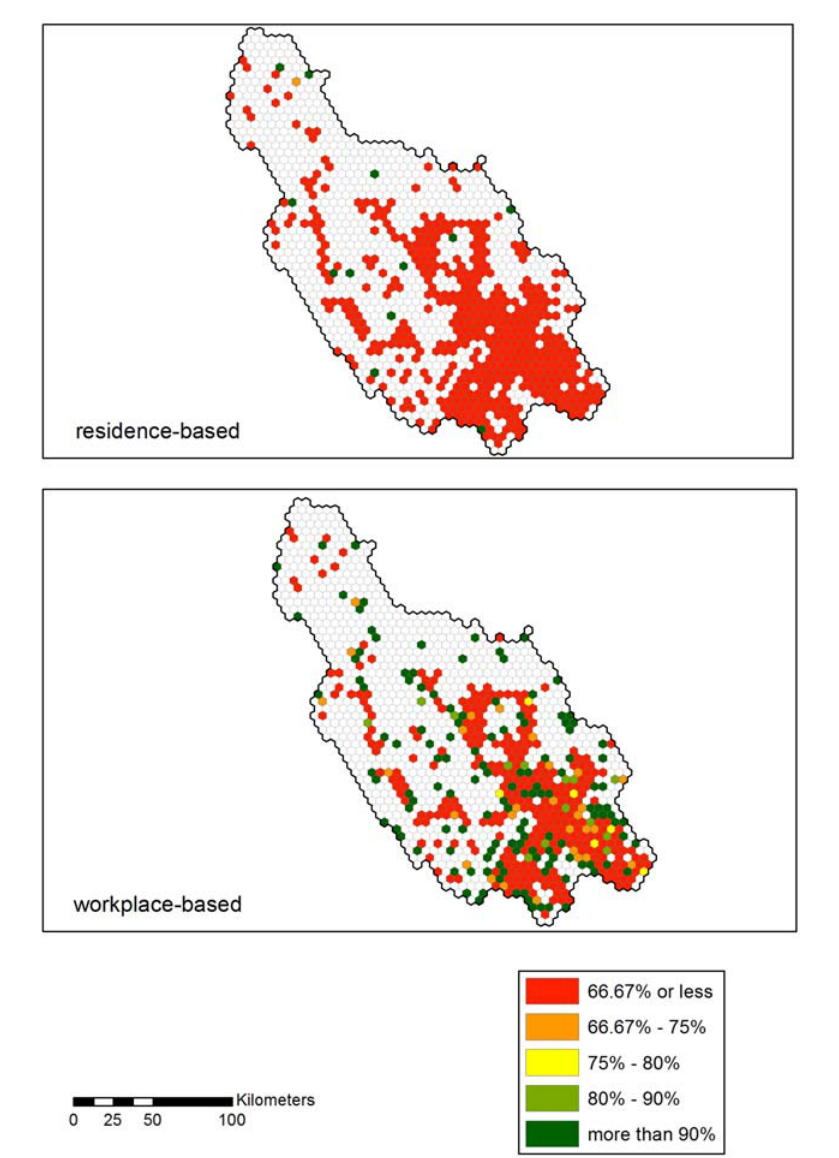
Figure 3. Residence-based and workplace-based